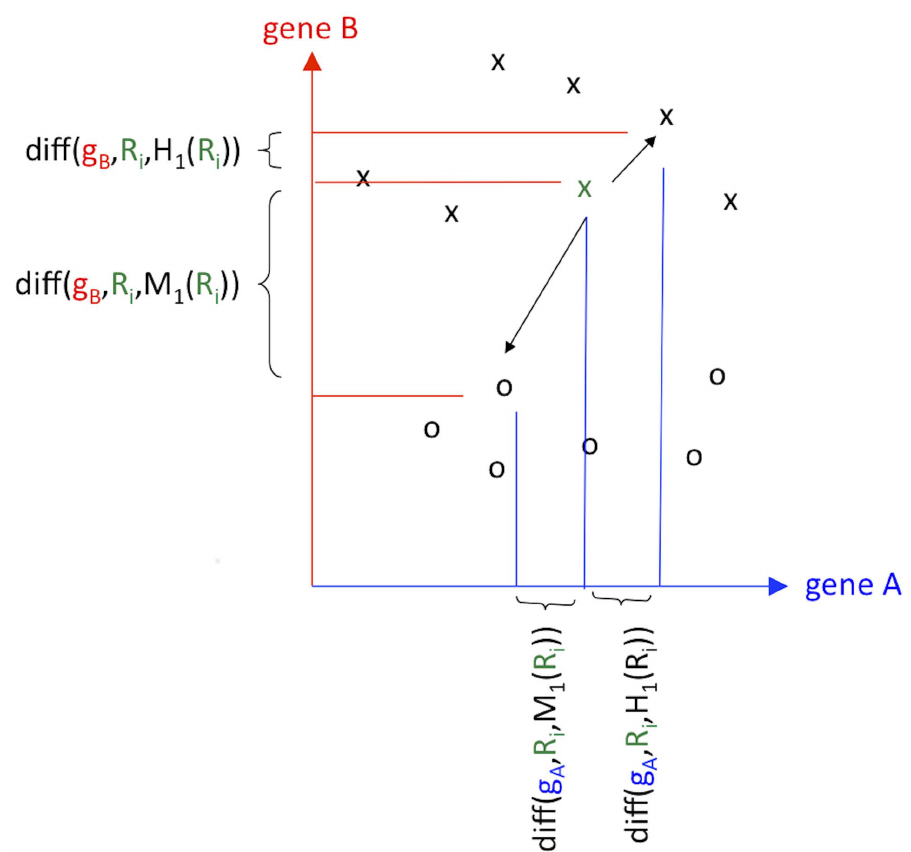
Figure 1. Two-dimensional (two gene) illustration of the gene-wise adaptive-k Relief-F algorithm. First, a subject Ri (green x in the figure) is selected and its nearest k hits and misses are found in the space of all genes. In the figure, k=1 is shown as an example, and the nearest hit of Ri (nearest 6 symbol) and its nearest miss (nearest circle symbol) are indicated by vectors (arrows) in the full space of genes. To estimate the contribution of subject Ri to the ability of each gene to discriminate between cases and controls, we calculate the difference (diff) in the expression of the gene between Ri and its hits and between Ri and its misses. These hit and miss differences are illustrated as projections onto the gene A (blue) and gene B (red) axes. Subject Ri contributes a positive discrimination for gene B because the difference between the miss projection and Ri is greater than the difference between the hit projection and Ri. Subject Ri contributes nearly 0 to the importance of gene A because the miss and hit projected differences are almost the same. These estimates of the differential expression of each gene are averaged for each subject (the above steps are repeated for each subject Ri). The above Relief-F algorithm is repeated for a range of k, resulting in each gene having an array of scores corresponding to each k. The highest Relief-F score is used for each gene.